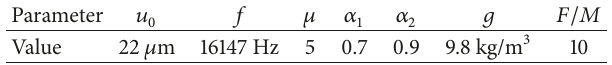
Table 1: Impact system parameters.